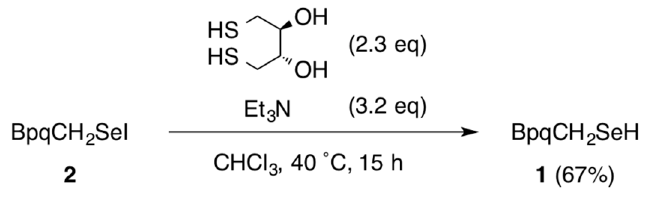
Scheme 3. Reduction of selenenyl iodide 2 .